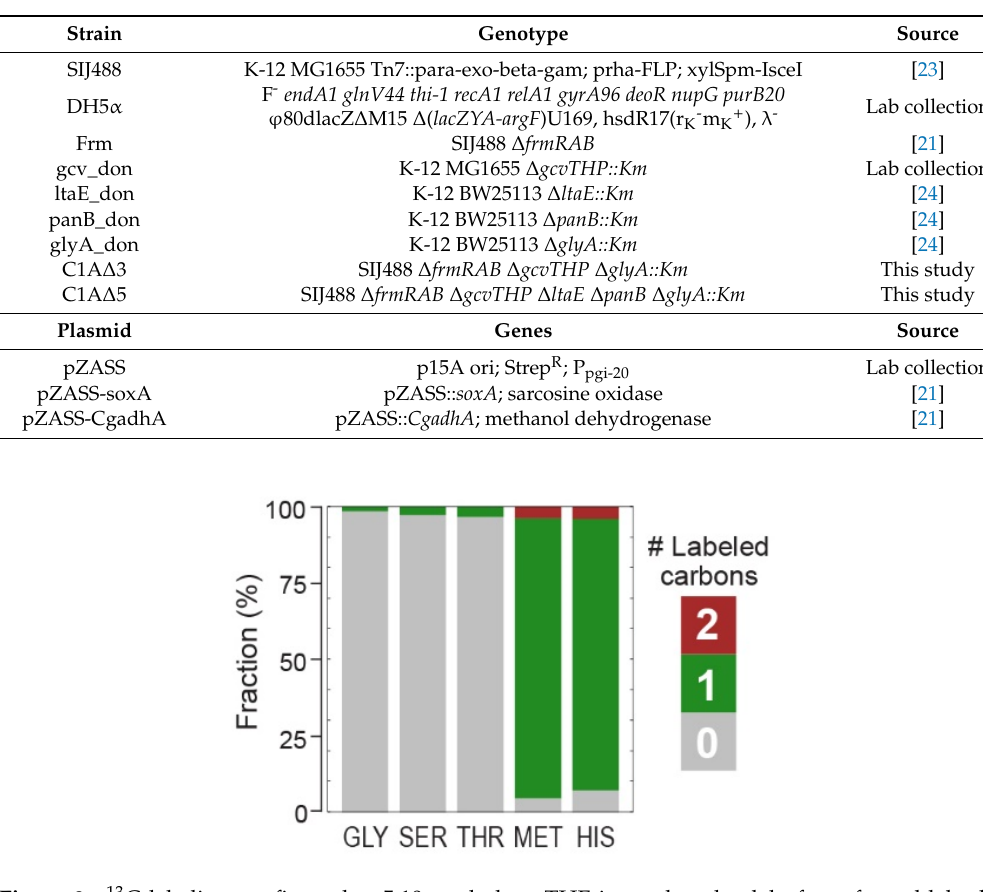
Figure 3. 13 C-labeling confirms that 5,10-methylene-THF is produced solely from formaldehyde. Labeling pattern of proteinogenic glycine (GLY), serine (SER), threonine (THR), methionine (MET), and histidine (HIS) upon feeding the C1A ∆ 3 strain with unlabeled glucose, glycine, thymidine, as well as sarcosine-(methyl- 13 C). Methionine and histidine contain a carbon derived from 5,10-methylene-THF and thus are fully singly labeled, while glycine, serine, and threonine serve as a control.